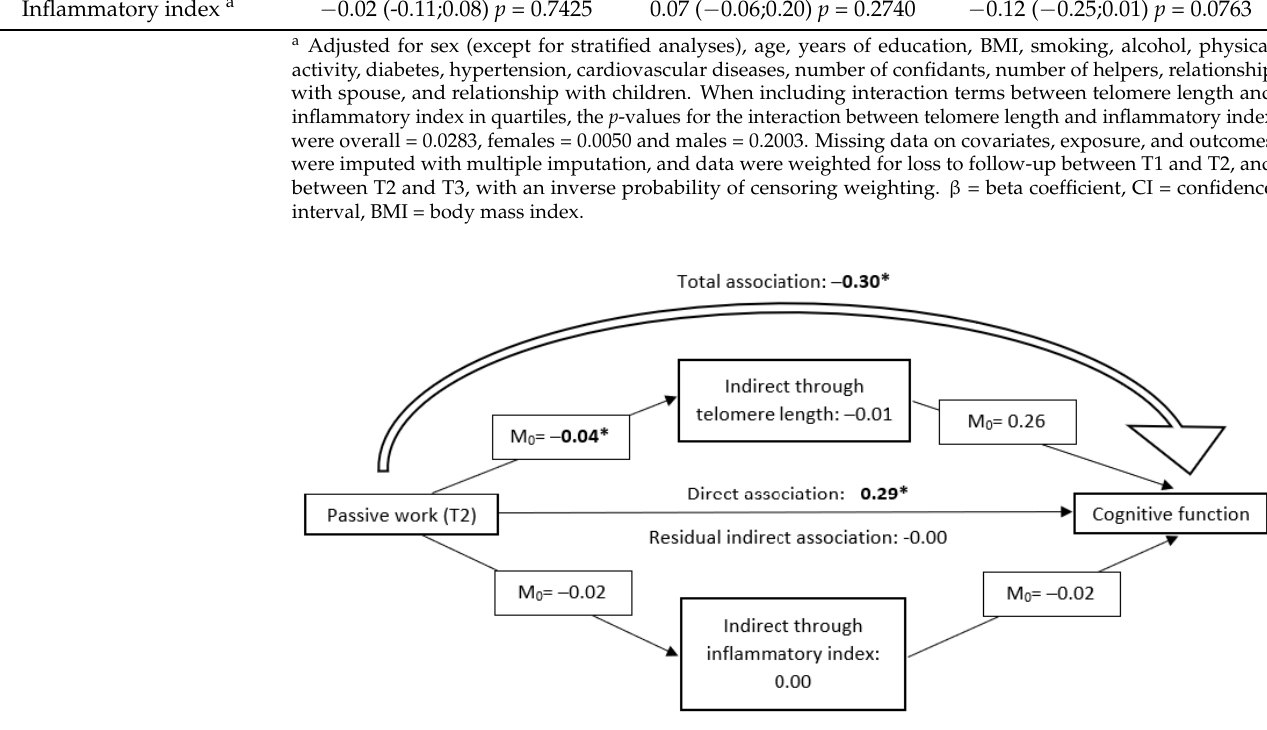
Figure 2. Illustration of the total, direct, and indirect associations through telomere length and inflammatory index, between exposure to passive work and global cognitive function. M 0 : Associations between exposure and mediators, or between mediators and global cognitive function. All associations were adjusted for age, sex, education, BMI, smoking, alcohol, physical activity, diabetes, hypertension, cardiovascular diseases, number of confidants, number of helpers, relationship with spouse, and relationship with children. Direct associations were additionally adjusted for inflammatory index, telomere length, inflammatory index squared, and interaction terms between telomere length and inflammatory index, and between telomere length and inflammatory index squared. Missing data on covariates, exposure, and outcomes were imputed with multiple imputation, and data were weighted for lost to follow-up between T1 and T2, and between T2 and T3, with an inverse probability of censoring weighting. * p < 0.05.